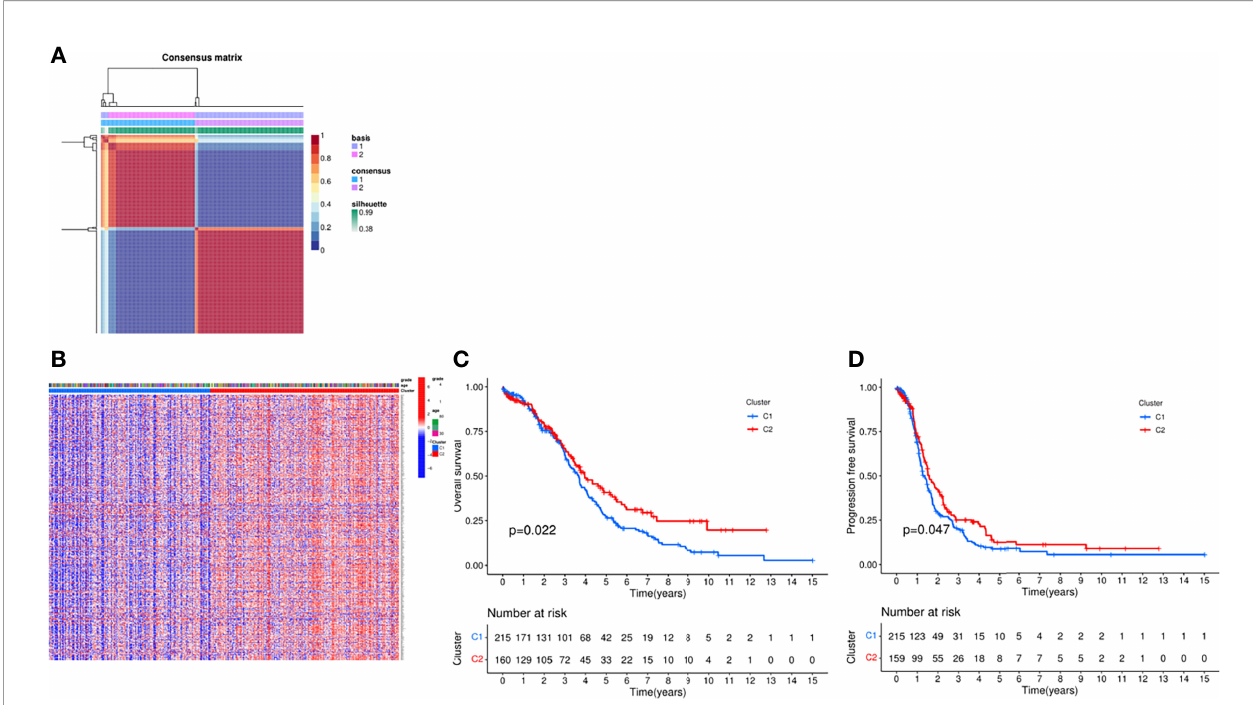
FIGURE 1 | Consensus clustering analysis of the patients via NMF algorithm. (A) NMF clustering using necroptosis-related genes. Patients were divided into cluster 1 and cluster 2. (B) Heat map of two clusters de fi ned by the necroptosis -related genes expression pro fi le. (C) Kaplan-Meier curve between two clusters via survival analysis in OS. (D) Kaplan-Meier curve between two clusters via survival analysis in